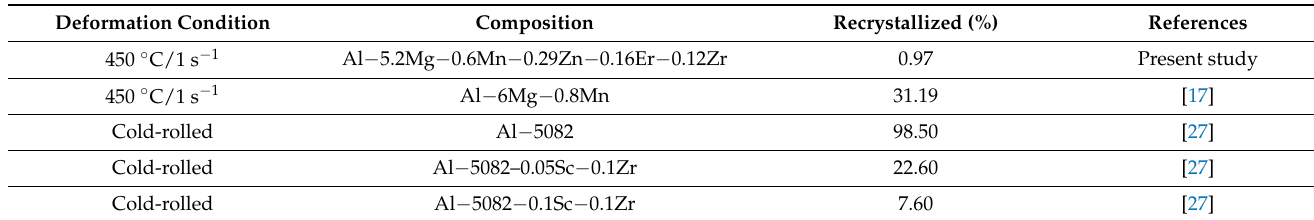
Table 3. Comparison of effect of Er and Zr on recrystallization fraction.